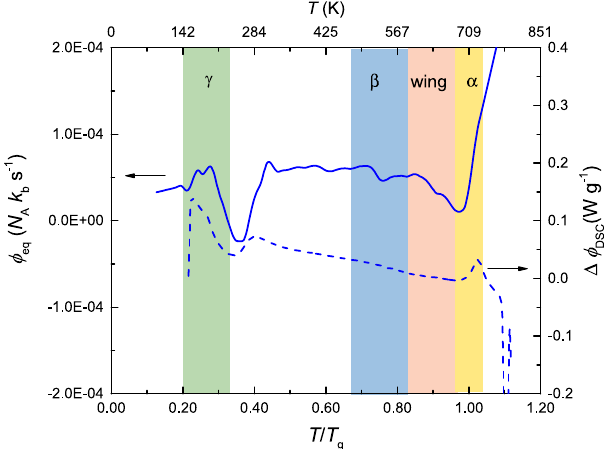
Fig. 4 Calorimetric (dashed line) and equivalent con fi gurational heat fl ow (solid line) for the as-cast state. At low temperatures, a very clear peak is observable — in contrast to the